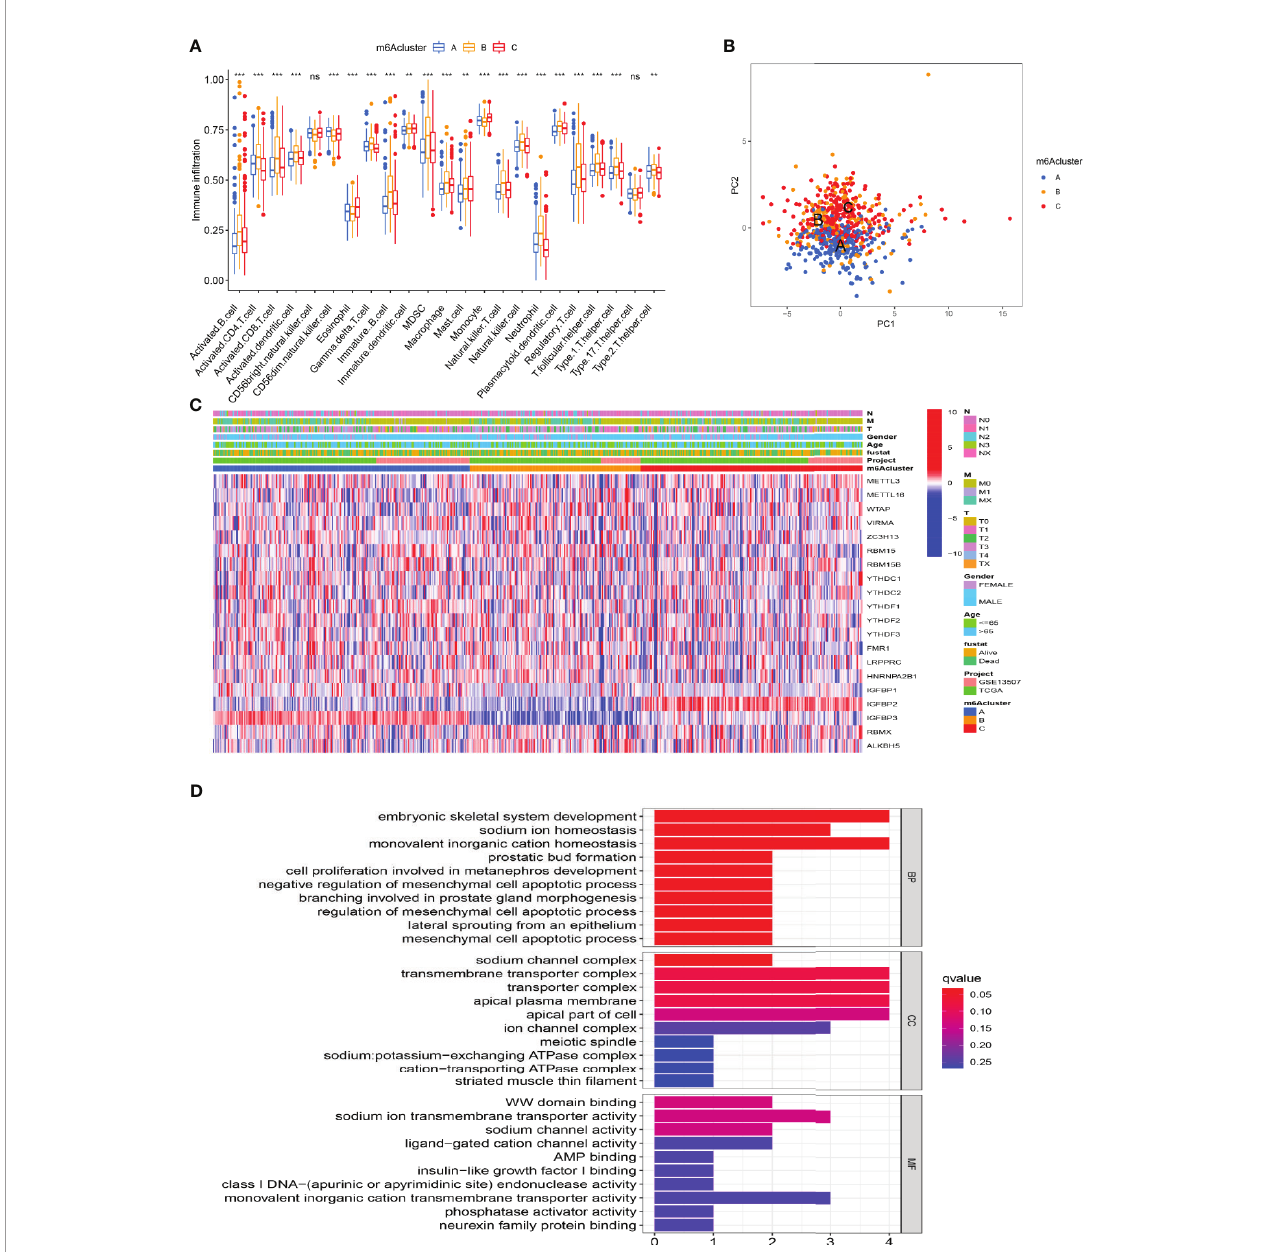
FIGURE 3 | Characterization of TME cell in fi ltration and transcriptome features in three m6A modi fi cation patterns. (A) The differential expression analysis of 23 immune cells among three m6A modi fi cation patterns. The *** represents p < 0.0001, ** represents p < 0.01 and ns represents no signi fi cance. (B) The scatter plot of PCA analysis. (C) Unsupervised clustering of 20 m6A regulators of bladder cancer. (D) GO enrichment analysis of m6A-related